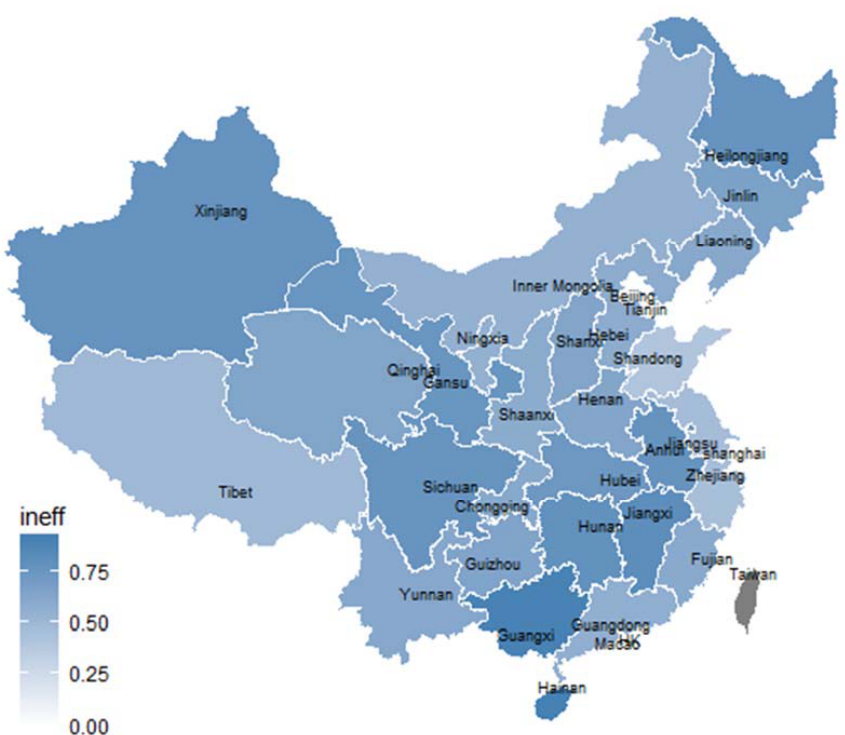
Figure 4. Eco-efficiencies of 31 provinces in China (A darker color indicates a lower Figure 4. Eco ‐ efficiencies of 31 provinces in China (A darker color indicates a lower eco ‐ efficiency). It can be found that only Beijing, Tianjin, and Shanghai were eco ‐ efficient in terms of water consumption in 2014 ( = 0  ). Guangxi and Hainan were the worst. Overall, the southeast and coastal areas were more eco ‐ efficient in terms of the water consumption, while the Midwest and the north were less eco ‐ efficient. The scores of eco ‐ inefficiency in terms of the water consumption of the remaining areas were almost between 0.5 and 0.9. This showed that the overall environment of water resources in China was not optimistic. In most areas, the water environment was polluted seriously and the economic effect of water consumption was low, which lead to the eco ‐ inefficiency of water consumption.